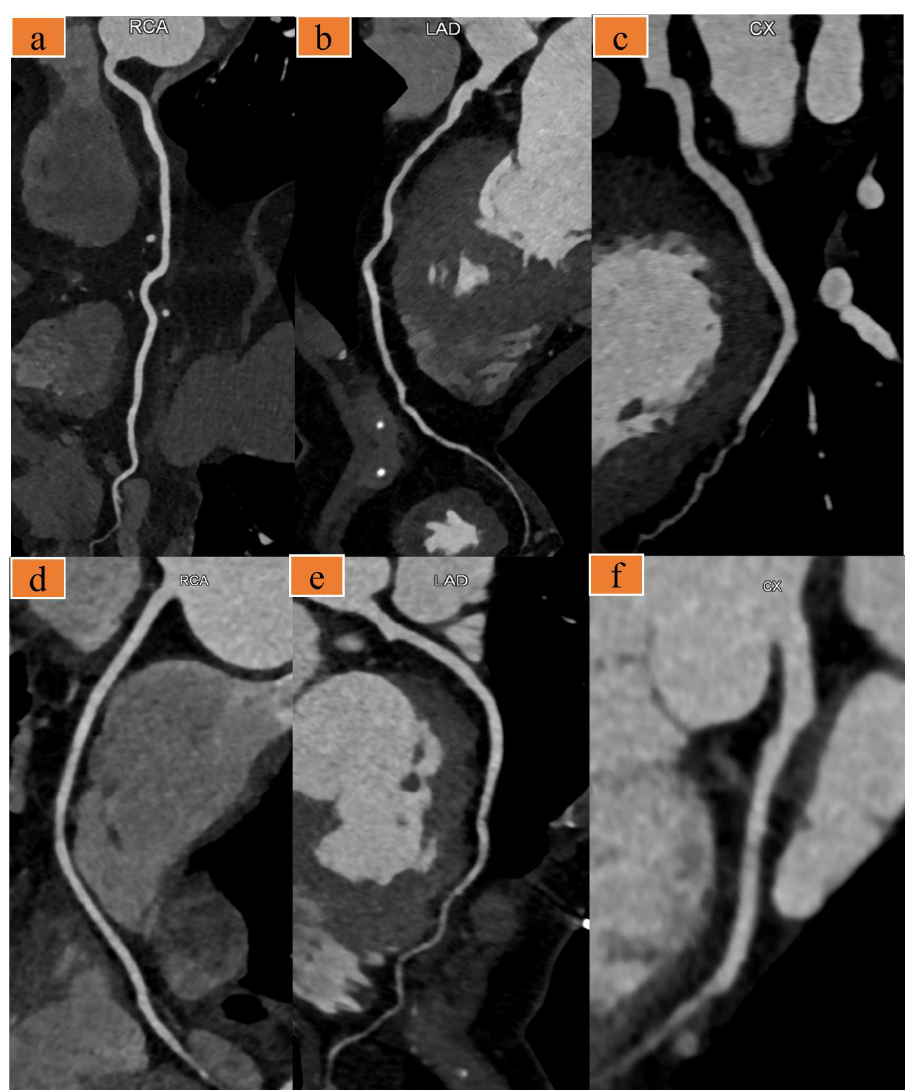
Figure 2. ( a – c ) A 91-year-old man with chief complaint of chest pain (heart rate: 67 bpm). Images were acquired with the optimized scanning scheme. Curved multiplanar reformat computed tomography (CT) images show the right coronary artery ( a ), left anterior descending artery ( b ), and left circumflex artery ( c ). ( d – f ) A 63-year-old woman presented to the emergency room with several days of chest pain, heart rate 58 bpm. Images were acquired with the traditional triple-rule-out computed tomography angiography (TRO-CTA). Curved multiplanar reformat CT images of the right coronary ( d ), left anterior descending artery ( e ), and left circumflex artery ( f ).